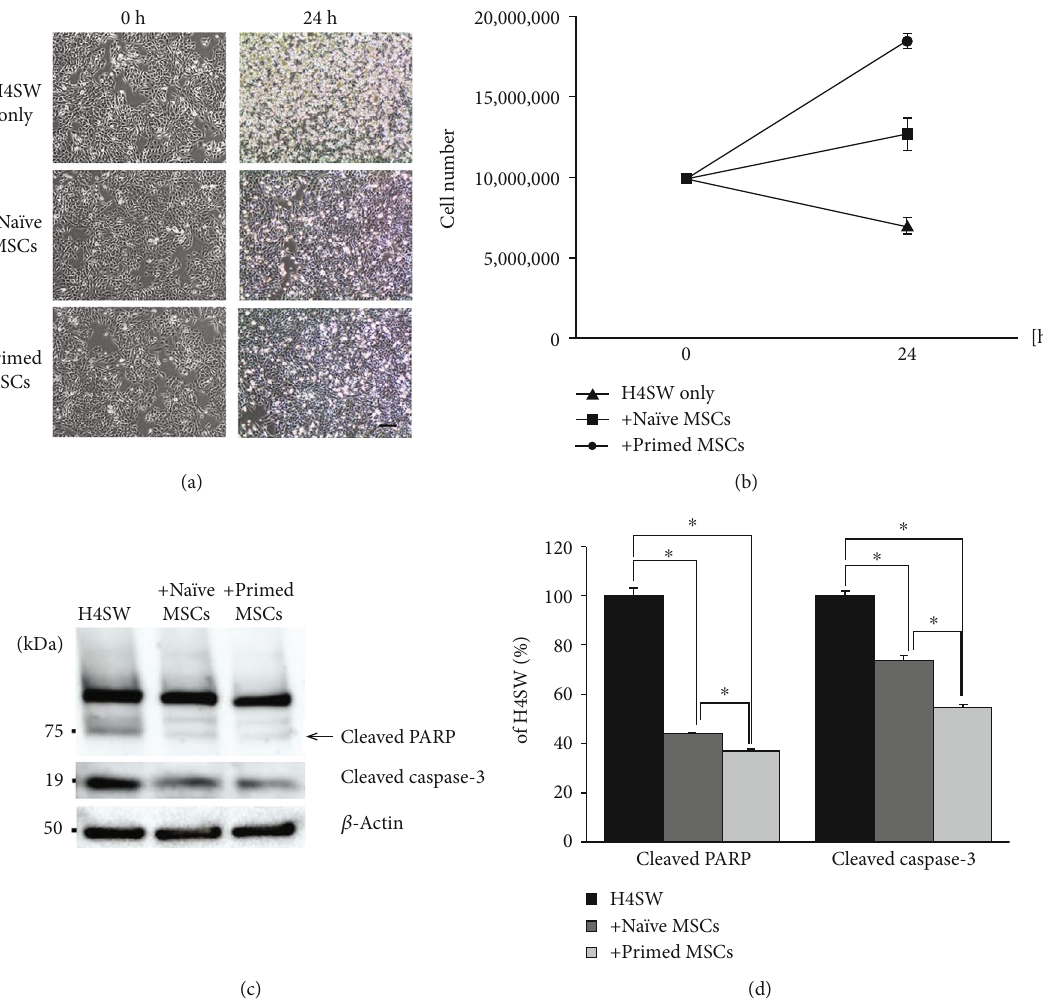
Figure 2: Antiapoptotic e ff ect of primed MSCs. (a) Images of serum-starved H4SW cells cocultured with naïve MSCs or primed MSCs for 24h. Scale bar: 40 μ m. (b) The number of viable cells in di ff erent experimental groups was counted by the trypan blue staining method. (c) Western blot analysis of cell death markers, cleaved PARP, and cleaved caspase-3. (d) The densitometry results are presented as fold change compared to H4SW cells. The data were normalized to β -actin expression. The data are presented as the mean ± S : E : M . Three samples per experimental group were tested in each assay. ∗ p < 0 : 05